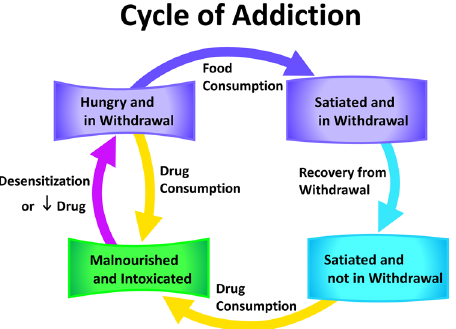
Figure 3. Four general states of ASIMOV’s forager in addiction. With enough food and learned associations for prey and Drug, the cycle leads to Drug seeking, consumption, and poor nutritional state. In withdrawal, hunger has a stronger effect on appetitive state, reducing selectivity for Drug and prey consumption. In this dual state of hunger and withdrawal, the forager can consume the Drug non-selectively, which, if easily available, leads to intoxication and malnourishment. Without Drug it can consume prey non-selectively, increasing satiation. As the forager becomes satiated and recovers from withdrawal, satiation increases its selectivity for the Drug. If enough Drug is available and consumed, the forager’s high positive reward experience reduces the effects of hunger to leave it in a state of malnourishment and intoxication. In this high reward experience, selectivity for the Drug is still increased (see Fig. 2, right), and if sufficient Drug is available, consumption continues to maintain high reward experience. If insufficient Drug is available, or if the forager is too desensitized to Drug reward, it falls into withdrawal, begins feeling the effects of hunger more acutely, and starts the behavioral cycle over again.